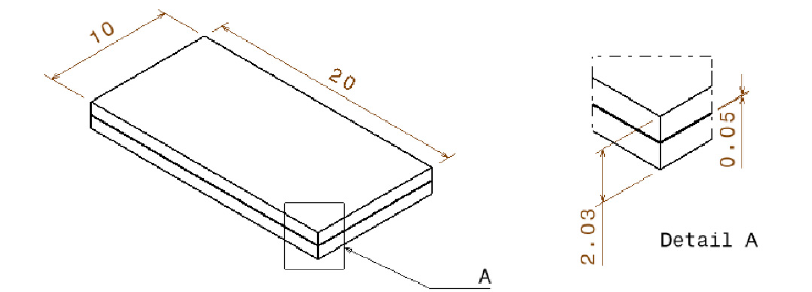
Figure 1: Dimensions of the short beam specimen.